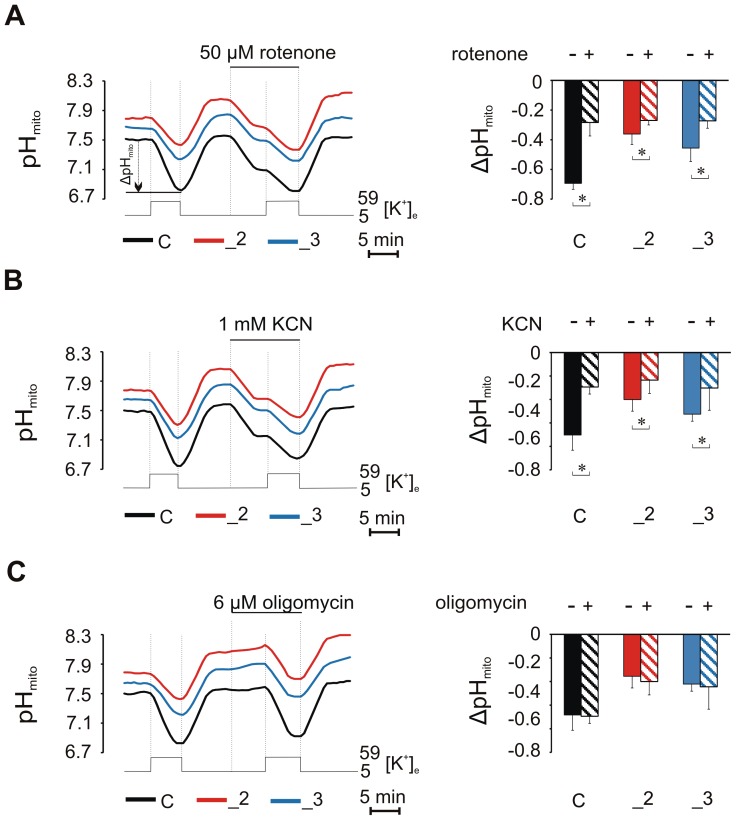
Contribution of electron transport chain (ETC) to mitochondrial H+ fluxes.The traces showing the effect of rotenone (A), KCN (B) or oligomycin (C) on 59 mM KCl-evoked pHmito responses in n = 10, n = 13, n = 15 for C, _2, _3 lines, respectively. The column graphs show the drug effects on pHmito loss. * P<0.05 drug treated vs. untreated.